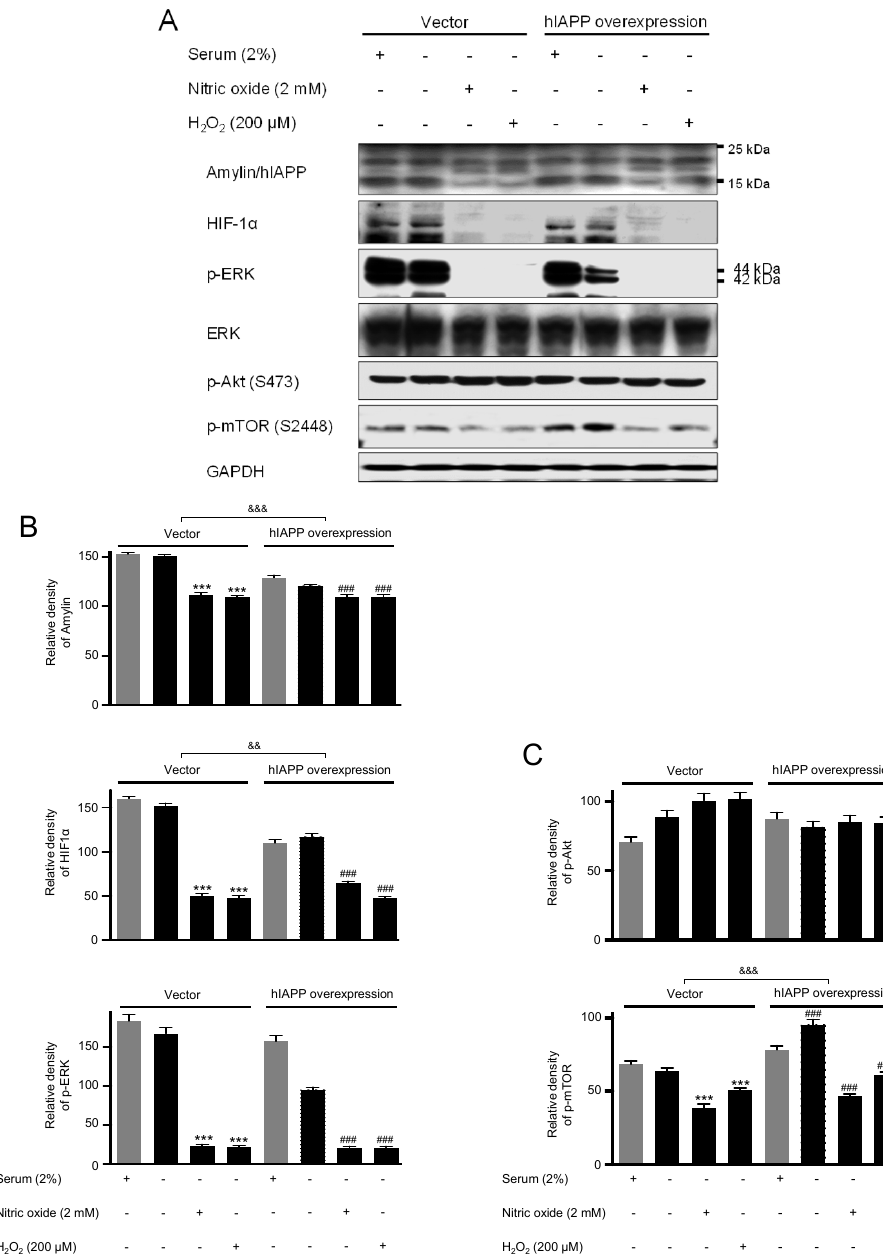
Figure 6. The expressions of amylin/hIAPP, HIF1 α , p-ERK, p-Akt, and p-mTOR proteins in pCMV-Entry-expressing cells and INS1E-hIAPP-overexpressing INS-1E cells under oxidative stress conditions. INS-1E cells were incubated in RPMI 1640 medium supplemented with/without 2% fetal bovine serum and/or nitric oxide (2 mM) or hydrogen peroxide (200 µ M) for 24 h at 37 ◦ C with 5% CO 2 . Amylin/hIAPP, HIF1 α , p-ERK, p-Akt, and p-mTOR were then analyzed by Western blot ( A ). The relative amounts of Amylin/hIAPP, HIF1 α , and p-ERK ( B ) and p-Akt, and p-mTOR ( C ) were quantified as described in Materials and Methods. Data represent the mean ± SEM of three experiments. *** p < 0.001 vs. 2% FBS in pCMV-Entry-expressing cells; ### p < 0.001 vs. 2% FBS in INS1E-hIAPP-overexpressing cells; && p < 0.01, &&& p < 0.001, pCMV-Entry-expressing cells vs. INS1E-hIAPP-overexpressing